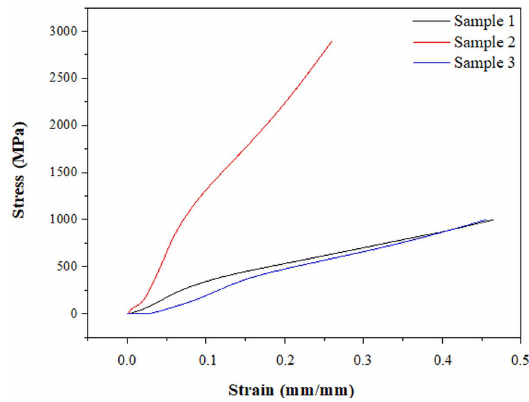
Figure 10. Stress-strain curves of X22CrMoV12-1 alloy obtained in the compressive strength